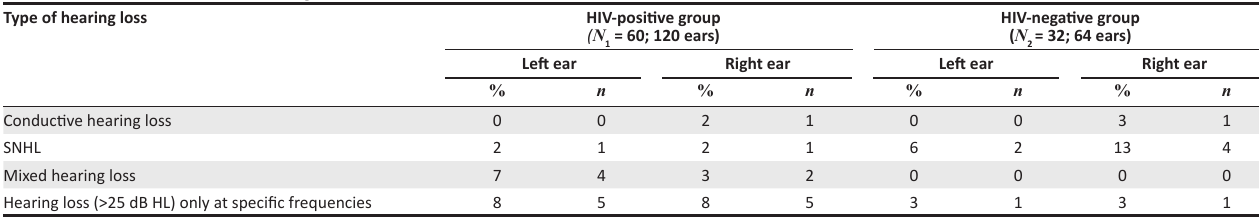
SNHL, Sensorineural hearing loss. TABLE 3: Prevalence of hearing loss and tinnitus in the current study in comparison to previous studies.